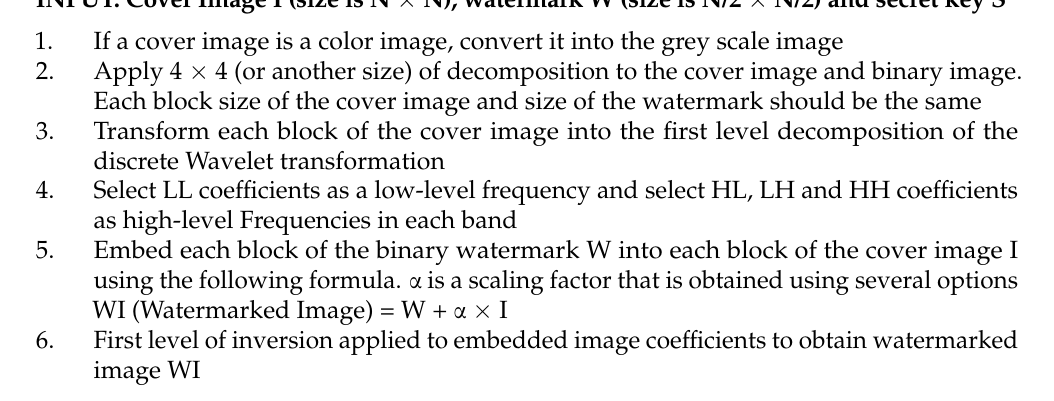
Algorithm 2 Block-based DWT Embedding Algorithm